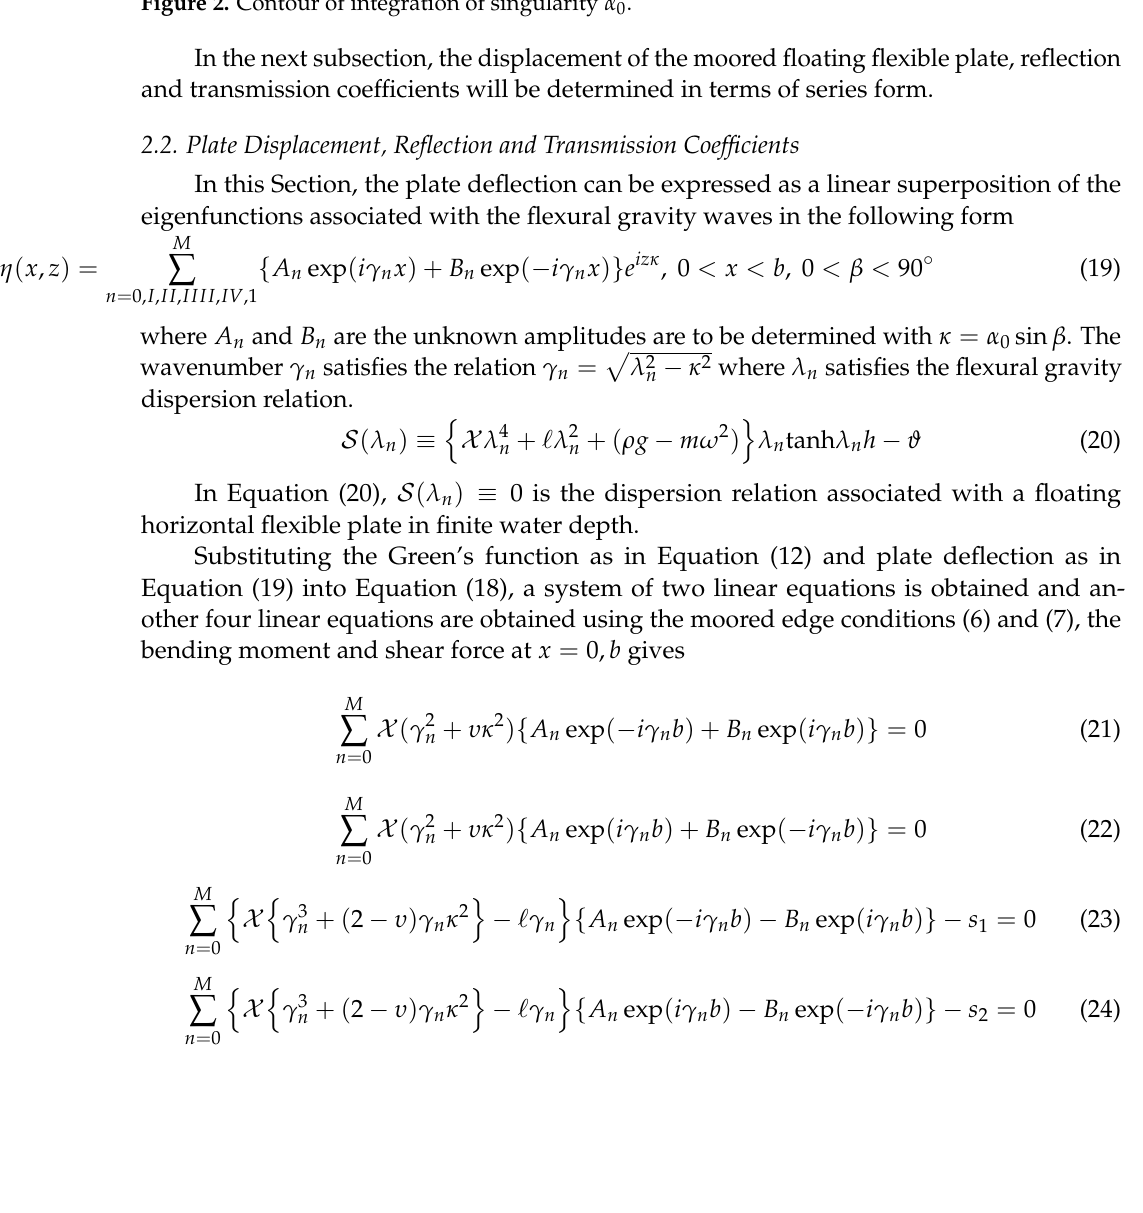
Figure 2. Contour of integration of singularity α 0